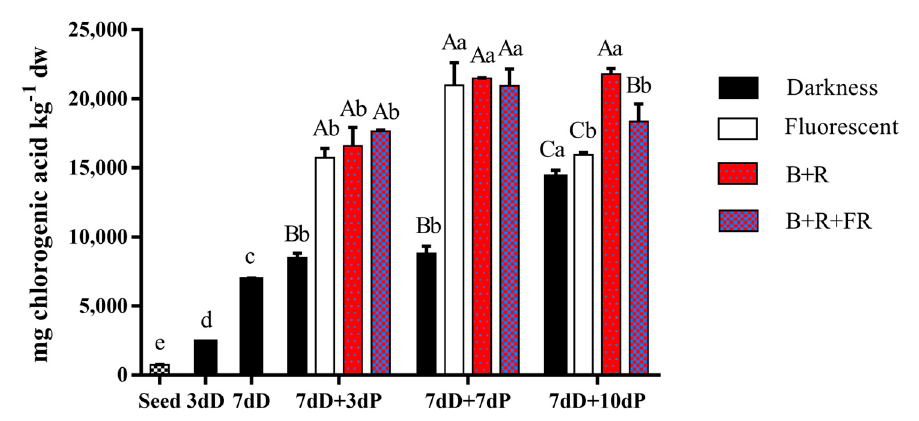
Figure 4. Total phenolic content of carrot sprouts grown at 20 °C during 7 days in darkness (dD)+3 or 7 or 10 days of a 16 h/8 h photoperiod (dP) under several light treatments. B+R: Blue+Red; B+R+FR: Blue+Red+Far-Red LEDs. Different capital letters indicate significant differences among treatments at p < 0.05 based on Tukey’s test. Different lowercase letters indicate significant differences among time of analysis of the same treatment at p < 0.05 based on Tukey’s test.